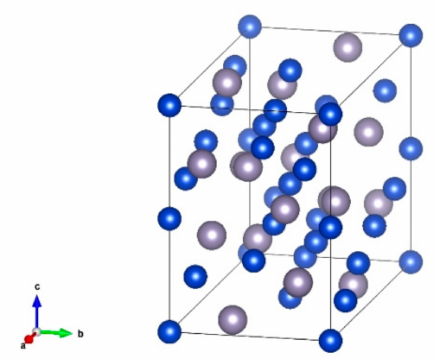
Figure 1. Cu 6 Sn 5 ( η ’ phase) cell structure